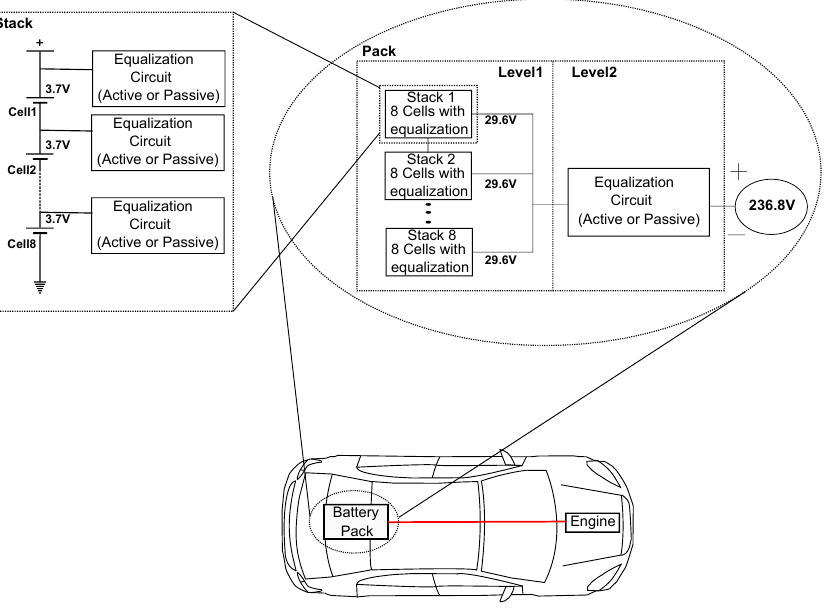
Figure 3. Schematic diagram of hybrid equalization topology.